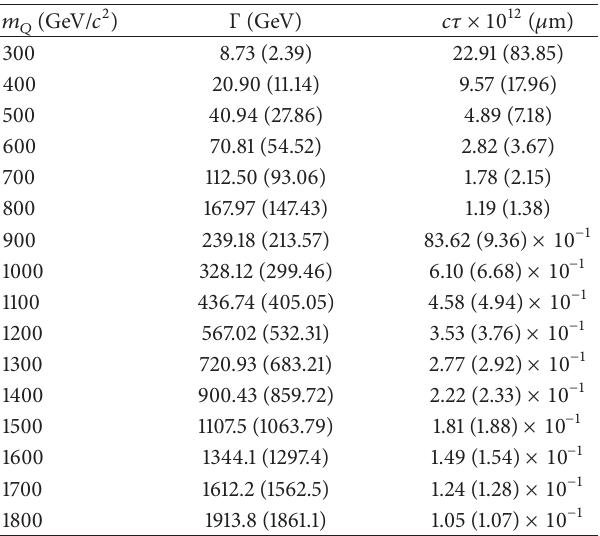
Table 3: Partial widths and decay lengths for a new heavy quark 𝑄 decaying to light quarks via on-shell charged currents 𝑄 → 𝑞𝑊 , with 𝑚 𝑞 = 0 and 173.2 GeV/ 𝑐 2 and |𝜅 𝑄𝑞 | = 1 , as computed from